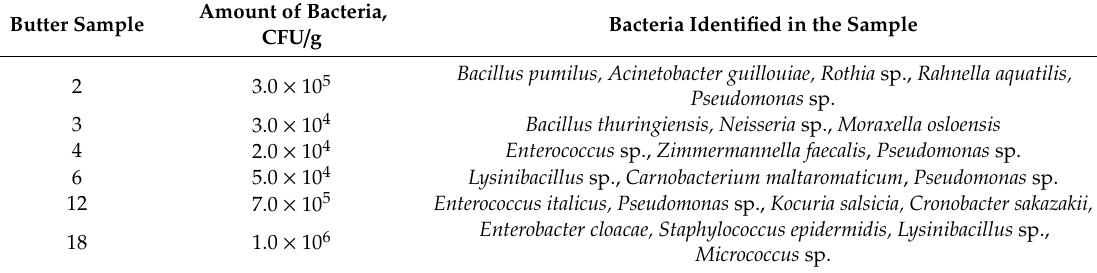
Table 3. Bacteria identified by Sanger sequencing of individual